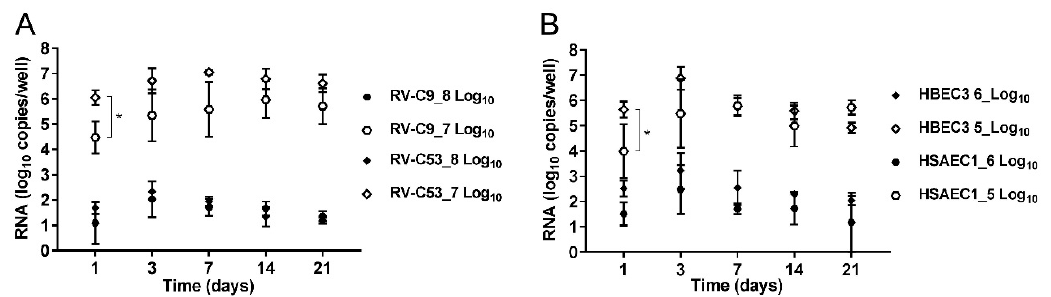
Figure 3. Increased RNA levels of RVs in HBEC3- and/or HSAEC1-ALI cultures. Data are expressed as log copies of RNA per well ( n = 3) at 1, 3, 7, 14, and 21 day(s) post-inoculation and normalized to the RNA concentration of PI (collected third wash solution) as 0. ( A ) Comparison of increased RNA levels between RV-C9 and -C53 in HBEC3-ALI cultures. Groups comprising inoculums of 8 log 10 RNA copies/well of RV-C9 (filled hexagons) and RV-C53 (filled diamonds), and 7 log 10 RNA copies/well of RV-C9 (open hexagons) and RV-C53 (open diamonds) were compared at each time point. ( B ) Comparison of increased RV-A16 RNA levels between HSAEC1- and HBEC3-ALI cultures. Groups comprising inoculums of 6 log 10 RNA copies/well of RV-A16 in HBEC3- (filled diamonds) and HSAEC1- (filled hexagons) ALI cultures and 5 log 10 RNA copies/well of RV-A16 in HBEC3- (open diamonds) and HSAEC1- (open hexagons) ALI cultures were compared at each time point. Differences in log RNA copies were analyzed by two-way ANOVA followed by Sidak’s multiple comparisons test. * p < 0.05.